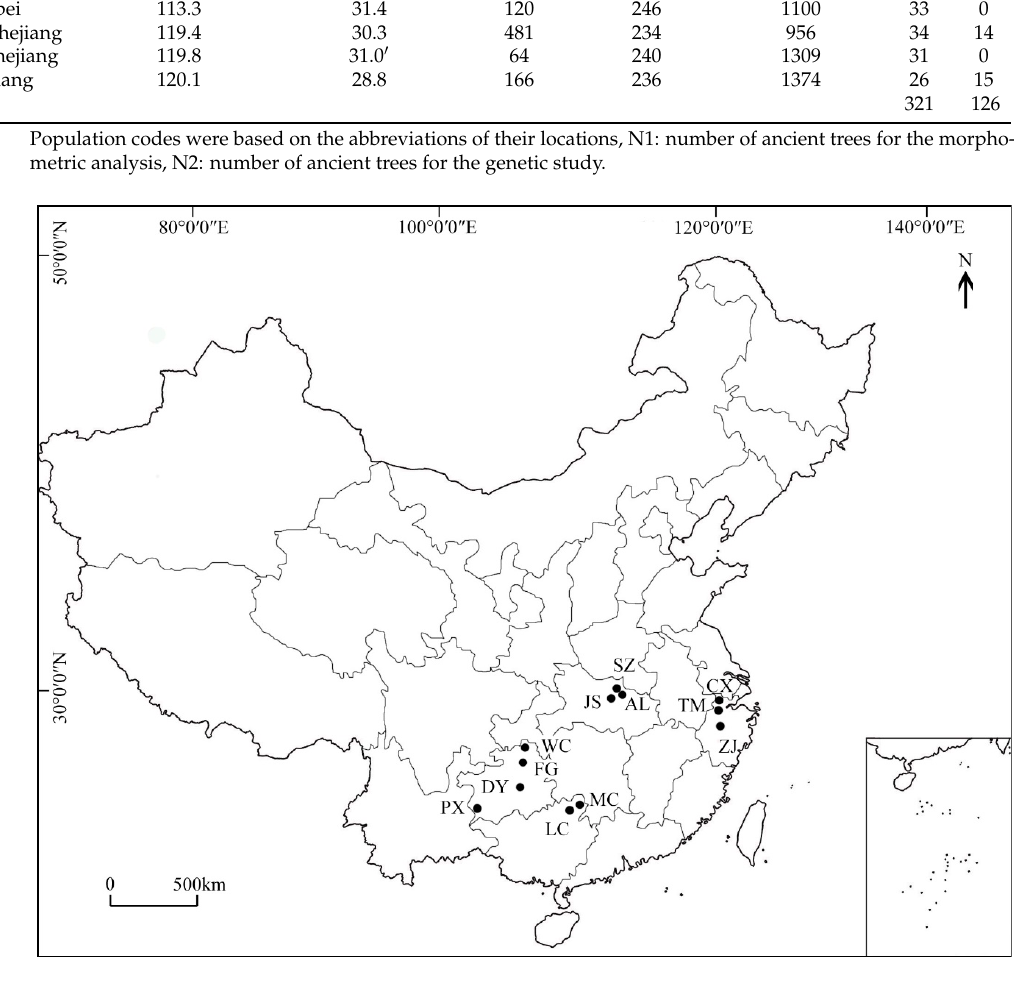
Figure 1. The distribution of Ginkgo biloba populations. Before the measurement of leaf traits, all the leaves of the samples were rinsed with water and placed in the shade to dry slightly for 1 h in order to remove dust from the surface of the leaves. First, leaf length (LL), leaf width (LW), petiole length (PL) and leaf thickness (LT) were measured on fresh materials by vernier calipers, and the length:width ratio (LWR) was calculated. The total thickness of fifteen leaves for each clone was meas- ured after overlapping, and the average thickness was taken as the measure of leaf thick- ness. Second, the leaves of each clone were scanned, and the leaf base angle (LBA) and leaf area (LA) were measured using Photoshop CS6 (Adobe Systems Incorporated, San Jose, CA, USA; Figure 2). Third, the total fresh weight of the leaves for each sample was weighed, and the average weight was taken as the measure of fresh weight (FW). Finally, the leaves were oven-dried at 65 °C to a constant weight for 6 h. The total dry weight of the leaves for each sample was determined, and the average weight was taken as the measure of dry weight (DW).